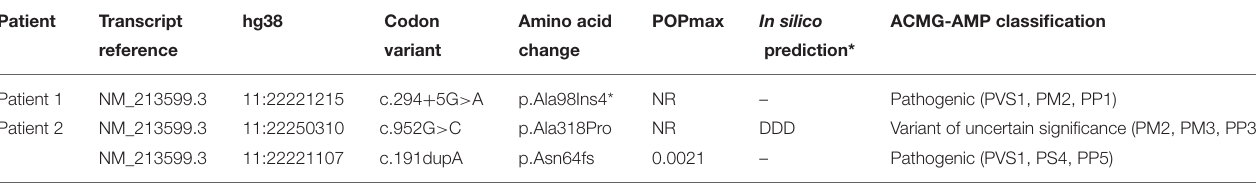
TABLE 1 | Genetic summary for ANO5